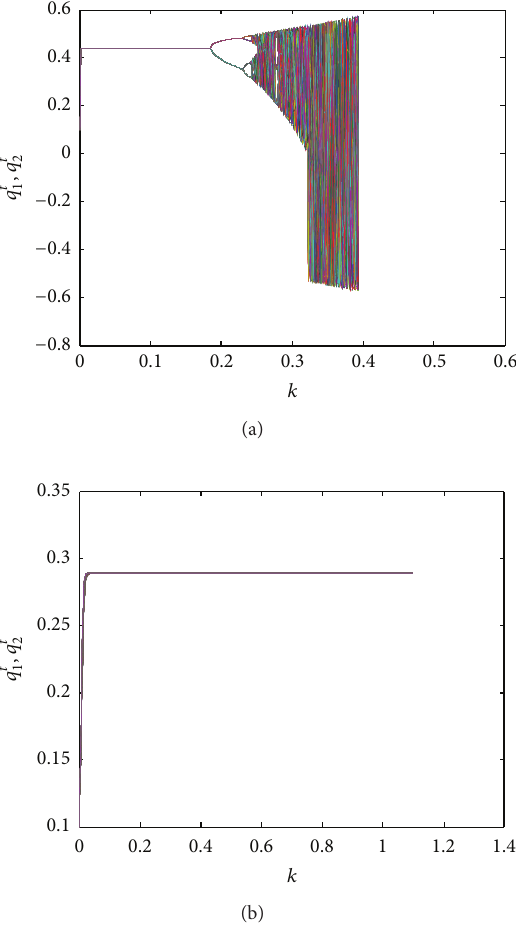
Figure 4: Bifurcation and chaos of the map (9) at the parameters: (a) 𝑎 = 3 , 𝑏 = 1.5 , 𝑐 = 0.3 ; (b) 𝑎 = 0.5 , 𝑏 = 0.3 , 𝑐 = 0.4